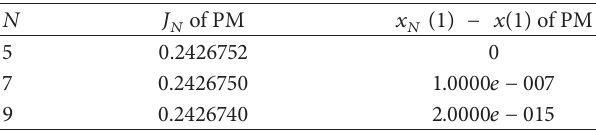
Table 3: Numerical results of Example